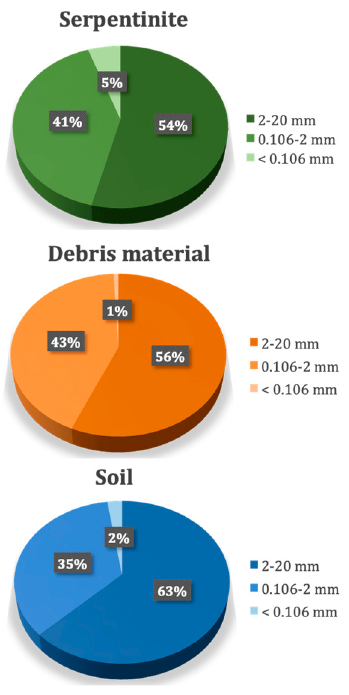
Figure 6. Pie charts illustrating the percentages of grains in the three studied grain size fractions for serpentinite, debris material, and soil for sieved (but not yet milled) material.